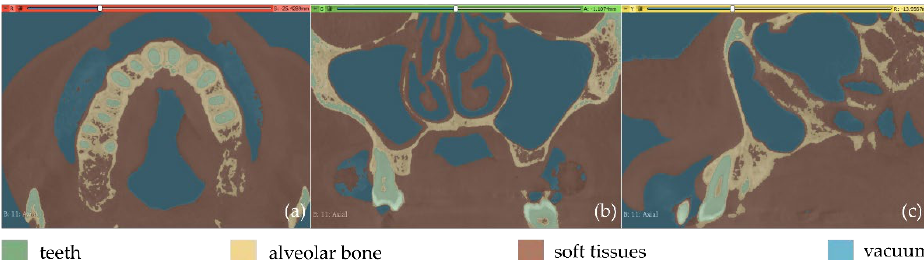
Figure 9. Automatic thresholding results for the segments defined for the teeth and the alveolar bone (Experiment 3); ( a ): a CBCT slice in the axial plane; ( b ): zoom-in view of ( a ).